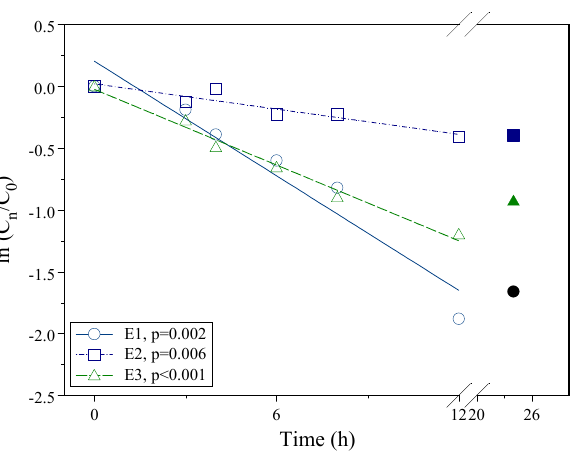
Figure 4. Estrogen concentration ratio ln (Cn/C 0 ) changed with time and linear regression curves for E1, E2, and E3. Table 5. The parameters of linear regression of average ln C n /C 0 changed with time for E1, E2 and E3. Table 4. The parameters of linear regression of average C n /C 0 ratios changed with time for the five detected compounds.